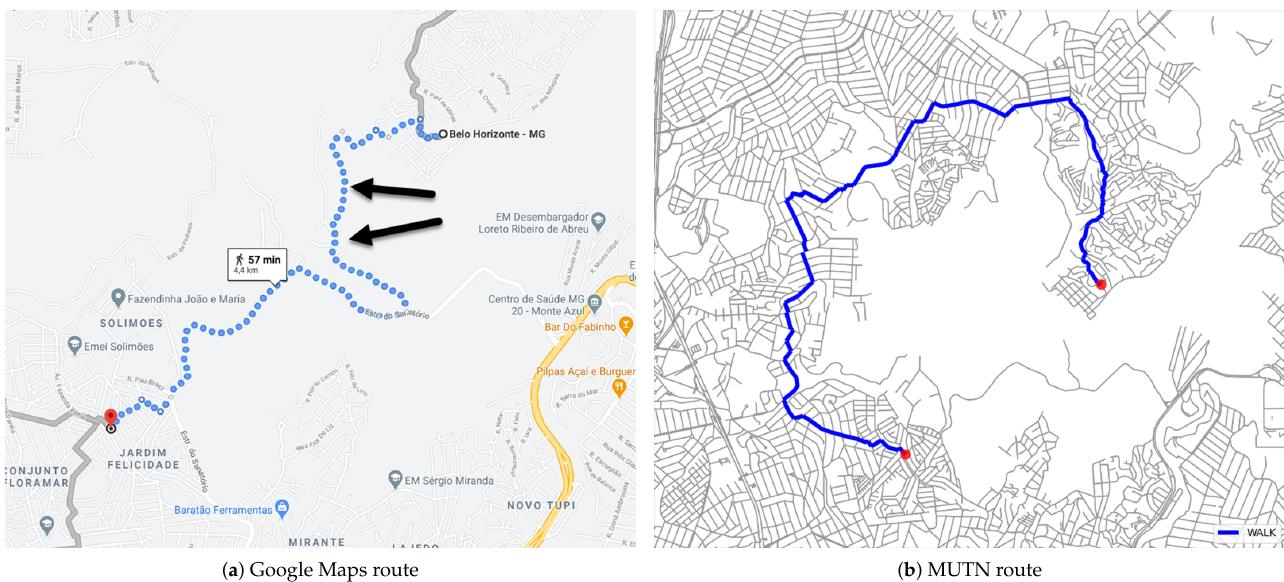
Figure 8. The difference in routes generated by Google Maps ( a ) and MUTN ( b ). Google Maps uses a path by apparently disconnected routes. Origin: (614152.9317131266, 7808868.689015543), destination: (614152.9317131266, 7808868.689015543),